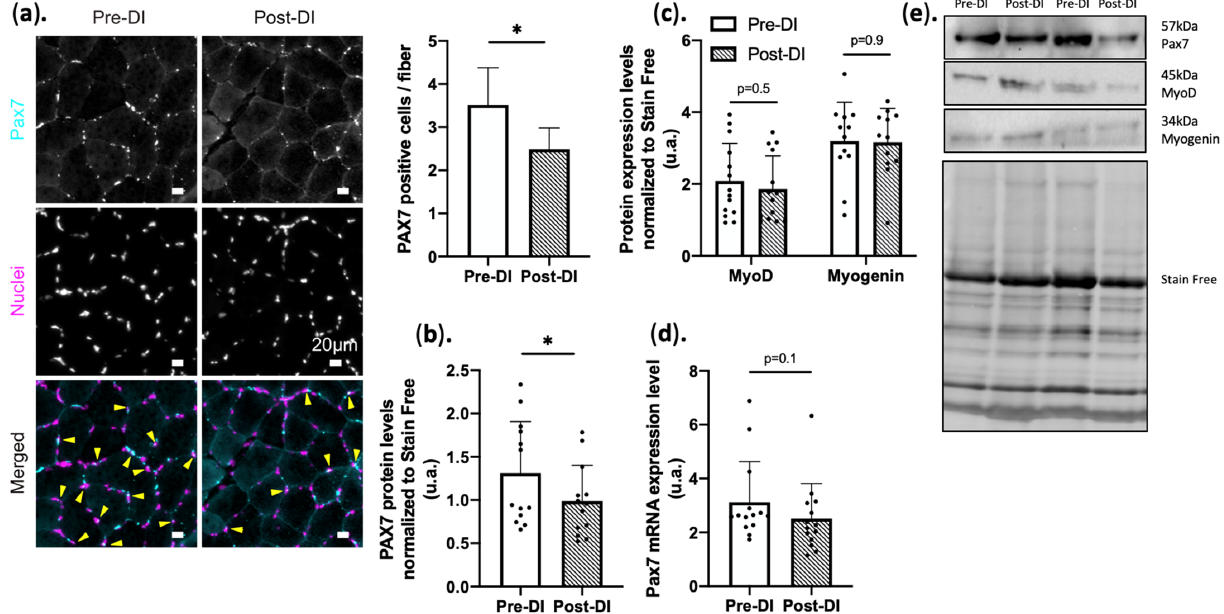
Figure 3. PAX7 ⁺ cell dynamics in VL biopsies before (Pre-DI) and after (Post-DI) 5 days of DI. ( a ) Representative images of Pre-DI and Post-DI vastus lateralis muscle sections stained with an anti- PAX7 antibody (cyan), Hoescht (Nuclei; Magenta), and Pax7/nuclei merged images; arrows corre- spond to colocalization of Pax7 and nuclei staining. Bar plot represents relative PAX7 signal after immunostaining paraffin-embedded transversal vastus lateralis sections from Pre-DI and Post-DI biopsies. ( b ) PAX7 protein levels in Pre-DI and Post-DI muscle biopsies, data were normalized to the total protein staining using Stain-free technology; n = 13/time point ( c ) MyoD and Myogenin protein levels in Pre-DI and Post-DI muscle biopsies, data were normalized to the total protein staining using Stain-free technology; n = 14/time point: MyoD; n = 12/time point: Myogenin ( d ) Gene expression of Pax7 in Pre-DI and Post-DI biopsies n = 14/time point; (e) Representative Western blot images and loading control ; * p < 0.05, Paired t -test or Wilcoxon matched-pairs signed-rank test was performed according to